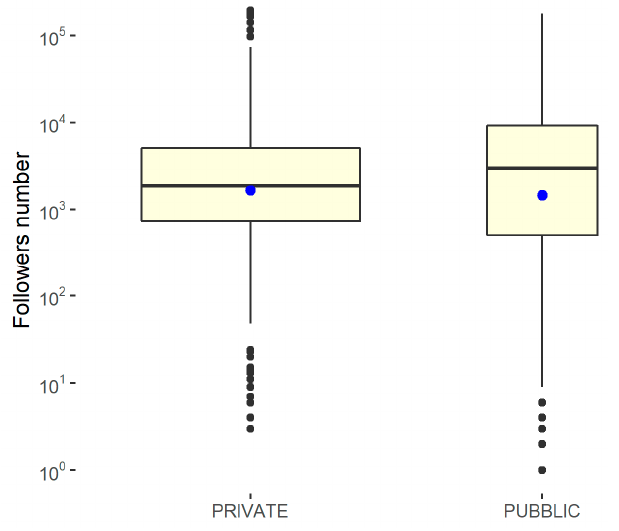
Figure 6. Kruskal–Wallis rank-sum test to determine the differences in the number of followers for the public/private hospitals. Kruskal–Wallis chi-squared = 1.1029, df = 1, p -value = 0.2936 (no significant difference).